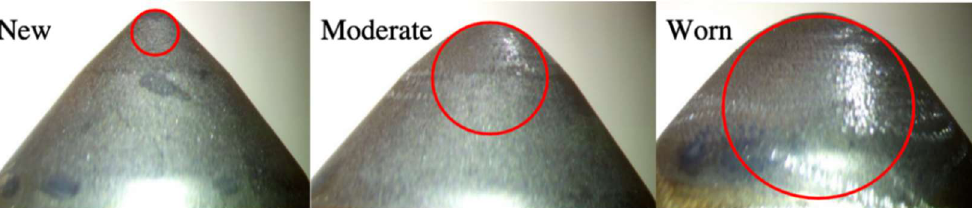
Figure 4. Comparison of a new, moderately worn, and worn pick tip with 0.7× magnification. A circle is superimposed to show the increase in pick tip radius with increase in wear.